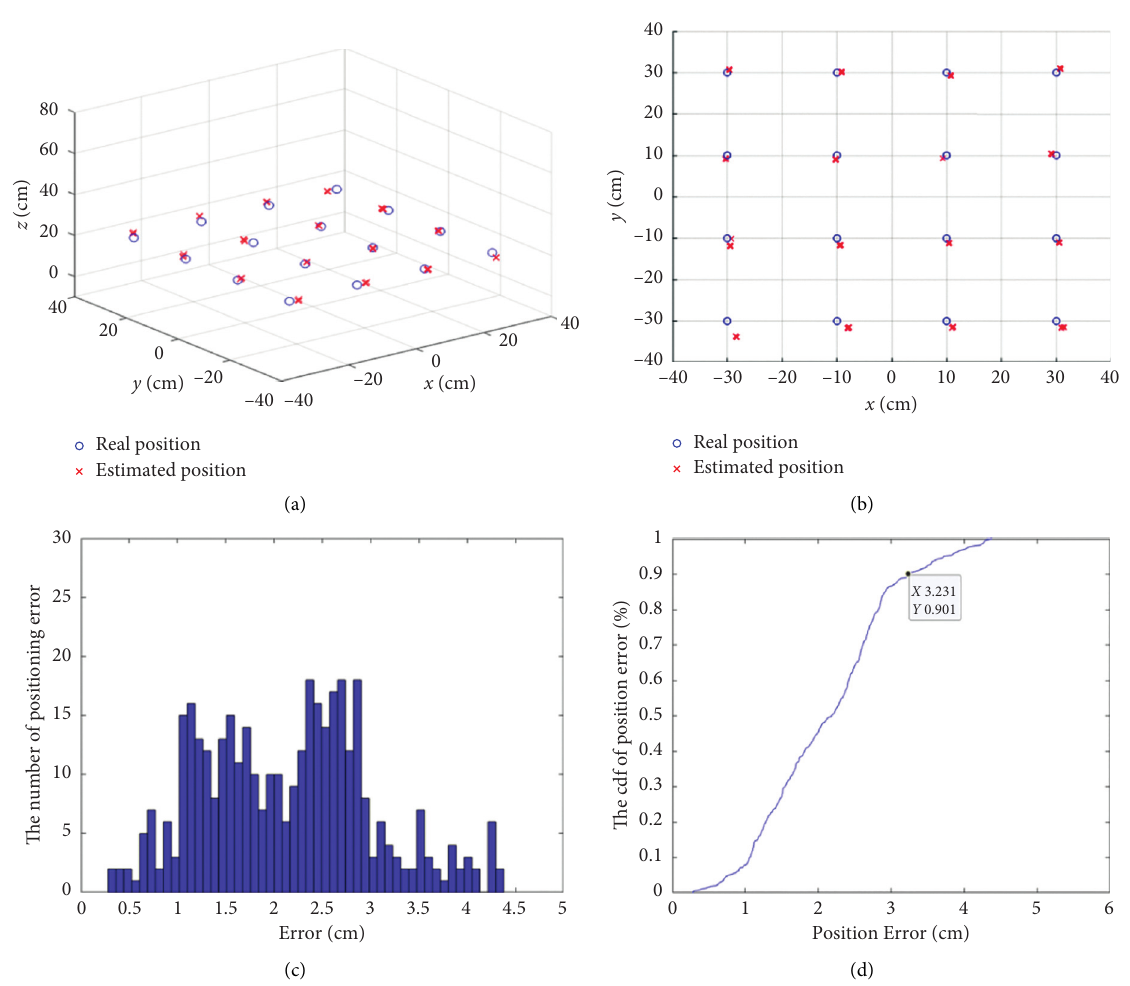
Figure 10: Stationary positioning of VLP-based robot system. (a) The 3D positioning results. (b) The horizontal view of the 3-D positioning results. (c) Histogram of the positioning error in the system. (d) The cumulative distribution function (CDF) curves of positioning